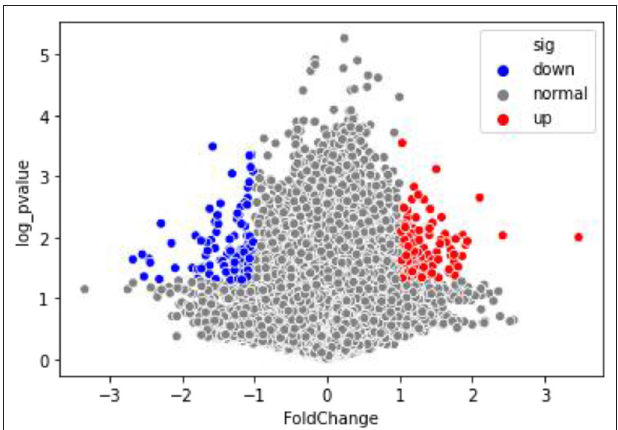
FIGURE 2 | The volcano map of